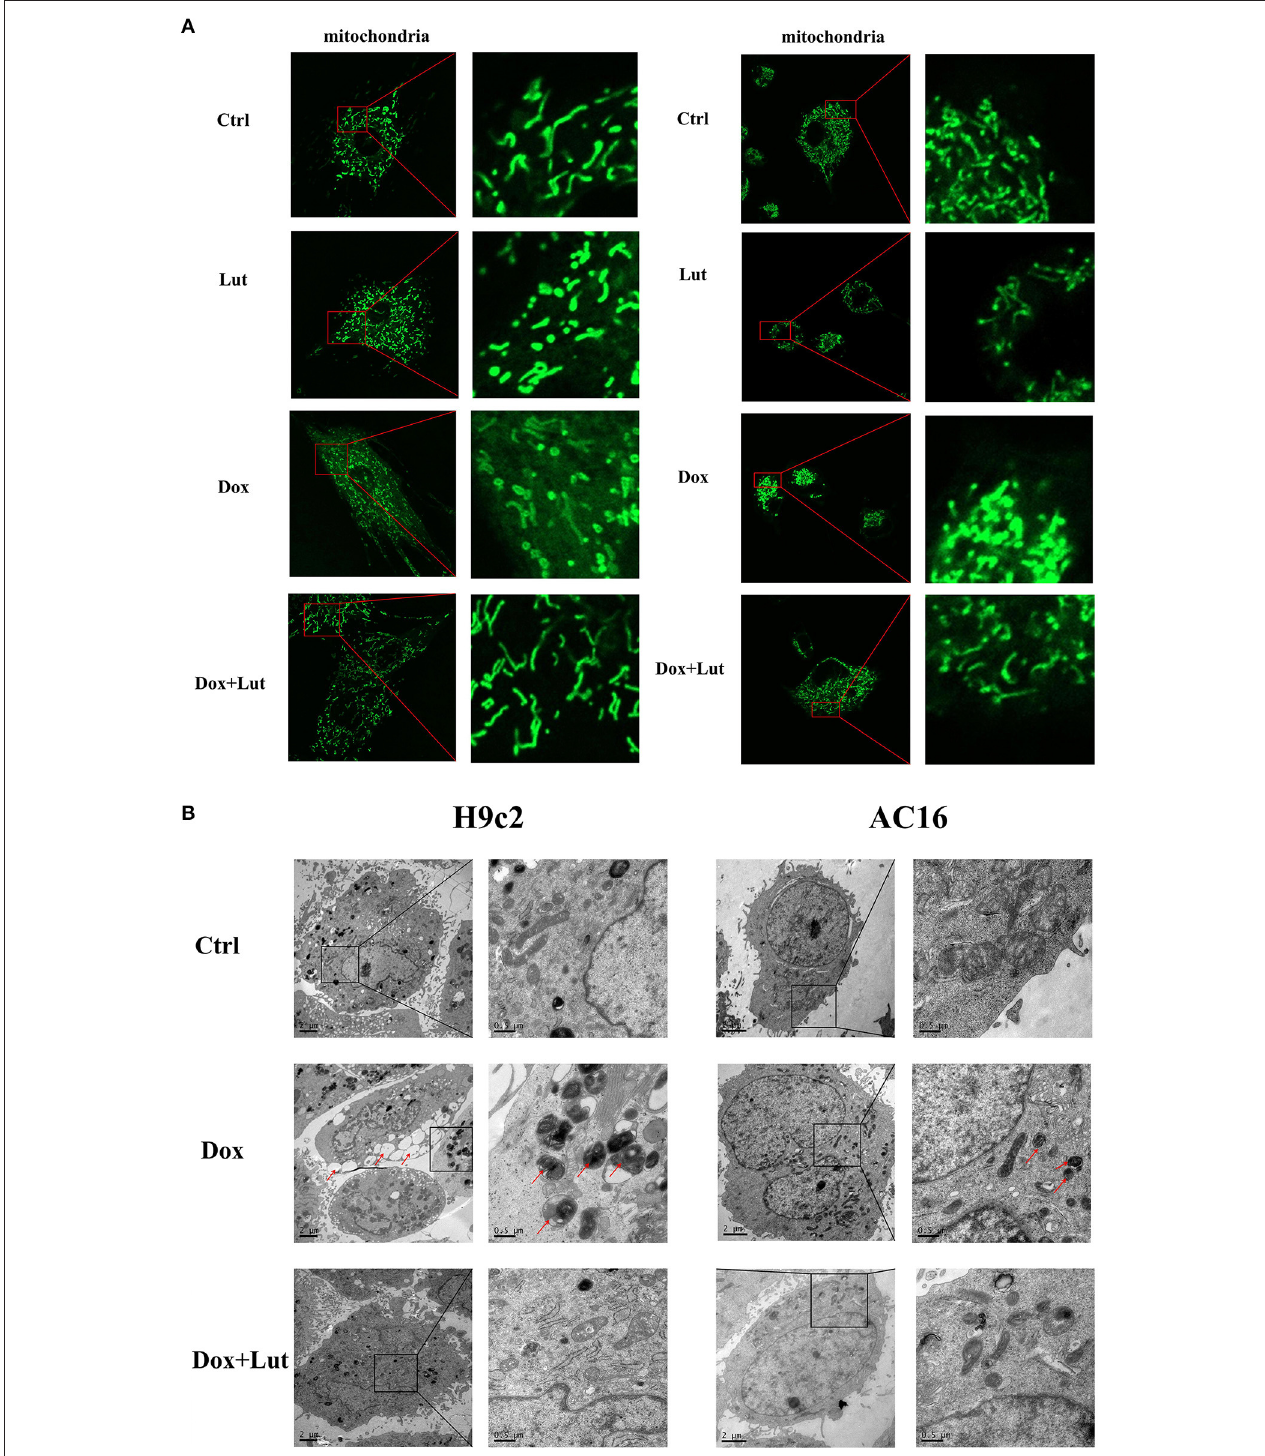
FIGURE 4 | Effect of Lut treatment on Dox-induced changes in cardiomyocyte mitochondrial morphology. (A) Representative fluorescence images of the morphology of mitochondria in H9c2 (left) and AC16 (right) cells (630 × ). (B) Transmission electron microscopy images of the morphology of mitochondria in H9c2 (left) and AC16 (right) cells (12,000 × ). Red arrows show